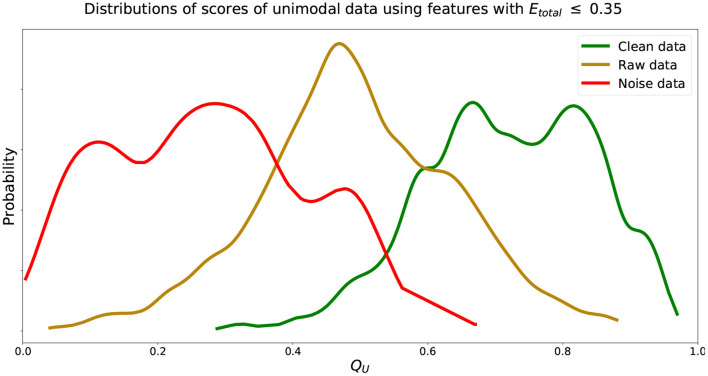
Estimated distributions of QU for CEye,model, REye,model, and NEye,model using features with Etotal, f ≤ 0.35. Distributions of QU of CEye,model and NEye,model intersect at QU = 0.53. Distribution of QU of REye,model centered at 0.47.